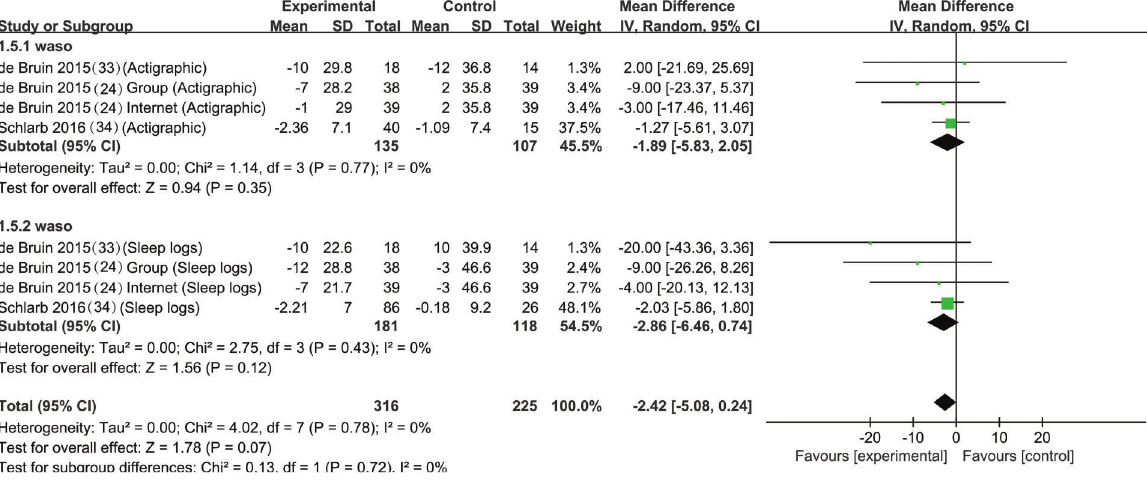
Figure 4. Meta-analysis of the effect of cognitive behavioral therapy for insomnia on wake after sleep onset (WASO).